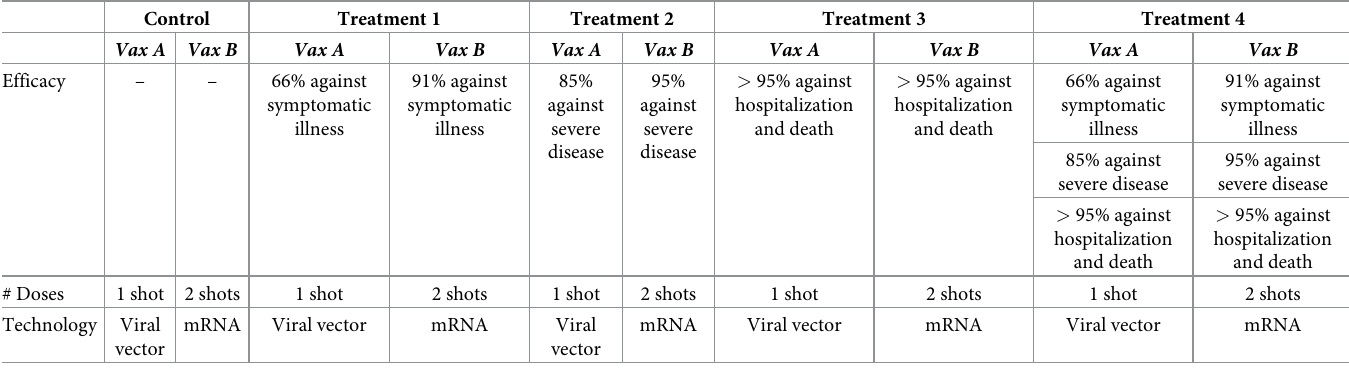
Table 2. Experimental